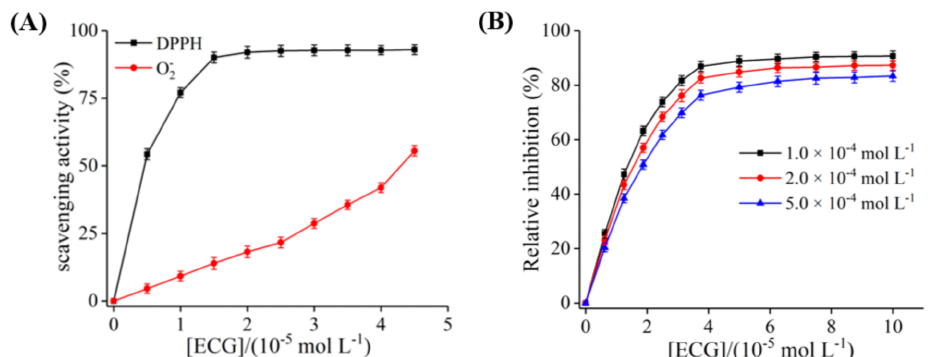
Figure 2. The antioxidant mechanism assay. ( A ) The scavenging effects of ECG on DPPH radical and O 2 − radical generated from phenazine methosulfate– β -NADH (PMS–NADH) system; ( B ) the inhibitory effects of ECG on the formation of O 2 − radical catalyzed by XO under different concentra- tions of xanthine. c (XO) = 0.7 µ M, c (xanthine) = 0.1, 0.2, and 0.5 mM,